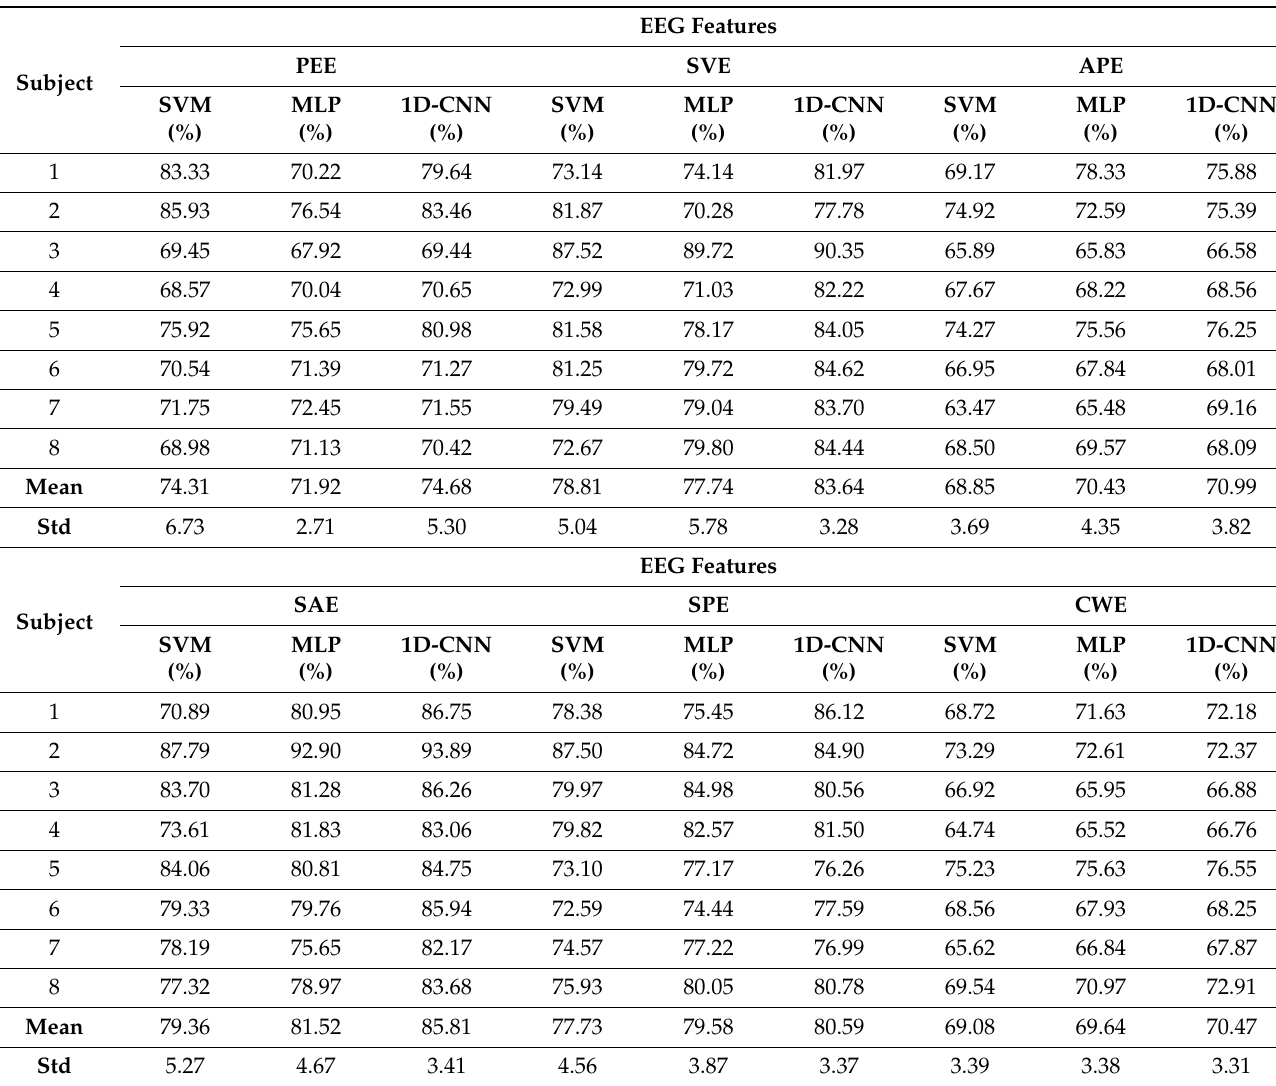
Table 3. Comparison of classification accuracy (%) between SVM, MLP, 1D-CNN with six features across eight